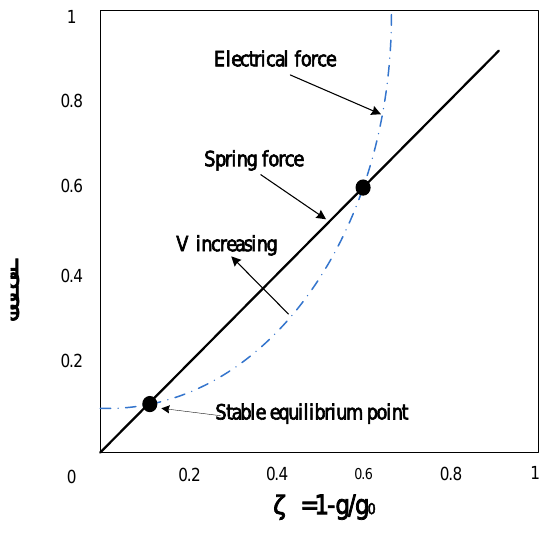
Figure 2. The electrical and spring force for voltage-controlled parallel-plate electrostatic actuator